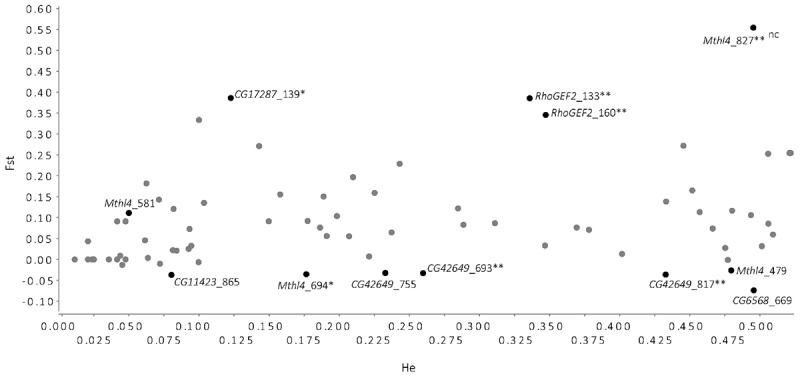
FST outlier analyses using FDIST2 method (Beaumont and Nichols, 1996) implemented in LOSITAN (Antao et al., 2008), based on 116 SNPs found in the sequences of the candidate genes in the D. melanogaster Field lines. This analysis identifies SNPs with excessively high or low FST values (calculated across all the Field lines) that fall outside the expected distribution of FST values for expected heterozygosity (He) levels, under the assumption of an island model of migration for neutral markers (Wright, 1931). The SNPs that fall within the 5–95% probability interval for the expected distribution of FST values are represented by gray dots, indicating putative neutral SNPs and are not labeled. SNPs that fall above the 95% confidence intervals have higher than expected FST values and are possible candidates for being under positive selection; SNPs that fall below the 95% confidence interval are likely candidates for being under balancing selection. Black dots represent SNPs that exceed the 5–95% probability interval, and are labeled with the SNP ID and with annotations (nc, non-coding; ∗non-synonymous change; ∗∗SNP that significantly changed in allele frequency in Selection and Control lines, see Jalvingh et al., 2014).